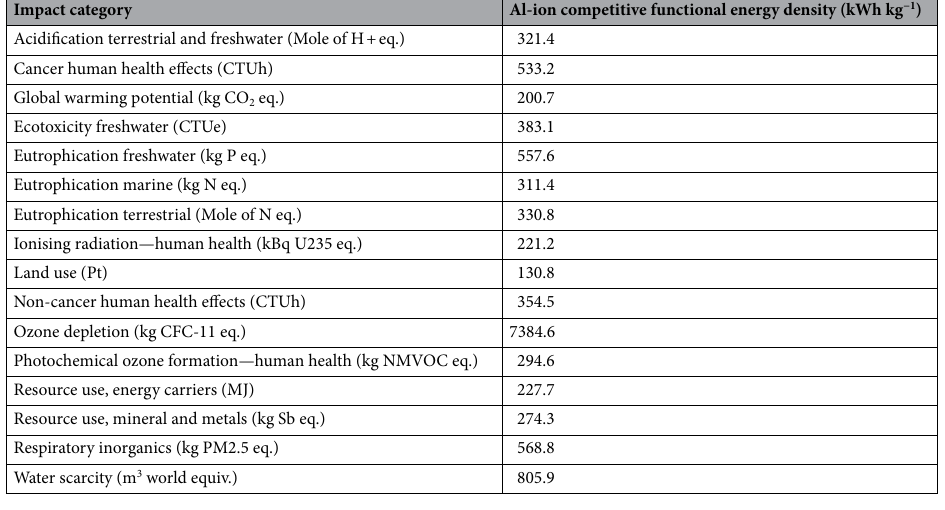
Table 1. Al-ion competitive functional energy density when compared with Li-ion values per kWh from (Siret 16